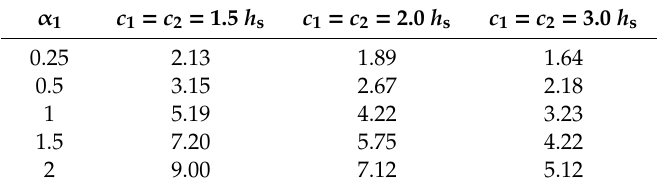
Table 2. Minimum values of the parameter α 2 , which satisfies the condition (2)—EC2.